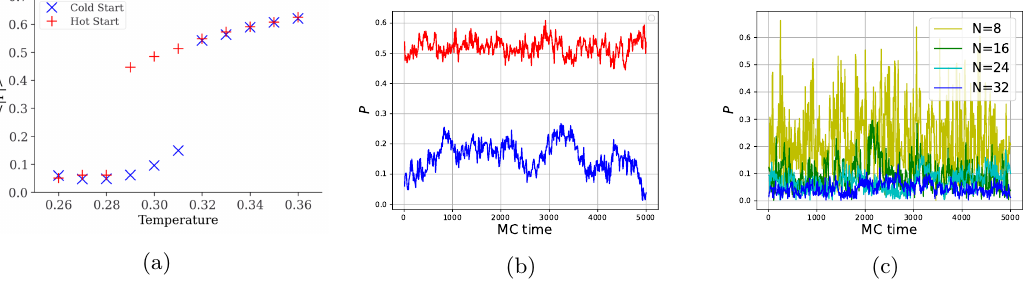
Figure 13. Numerical results for the Polyakov loop, P , in the theory with action in eq. (3.2). As discussed below eq. (3.3), our P is always real and non-negative. (a) Mean Polyakov loop versus temperature T , for N = 32 and n t = 24 . We observe strong hysteresis around T c ’ 0 . 31 , consistent with a first-order transition. The cold start (blue crosses) and hot start (red plus signs) simulations had initial temperatures T = 0 . 2 and T = 0 . 45 , respectively. The simulations were then thermalised before 200 configurations taken for data collection. (b) The simulation history of P for N = 32 and n t = 24 at T = 0 . 31 , for a cold start (blue) and hot start (red). The horizontal axis is the Monte Carlo time. We observe that tunneling between the two phases is strongly suppressed. The fluctuations are larger in the confined phase because T = 0 . 31 is close to the endpoint of the confined phase (the Hagedorn temperature). (c) The simulation history of P for N = 8 , 16 , 24 and 32 , with n t = 24 , at T = 0 . 25 . As N becomes larger, P approaches